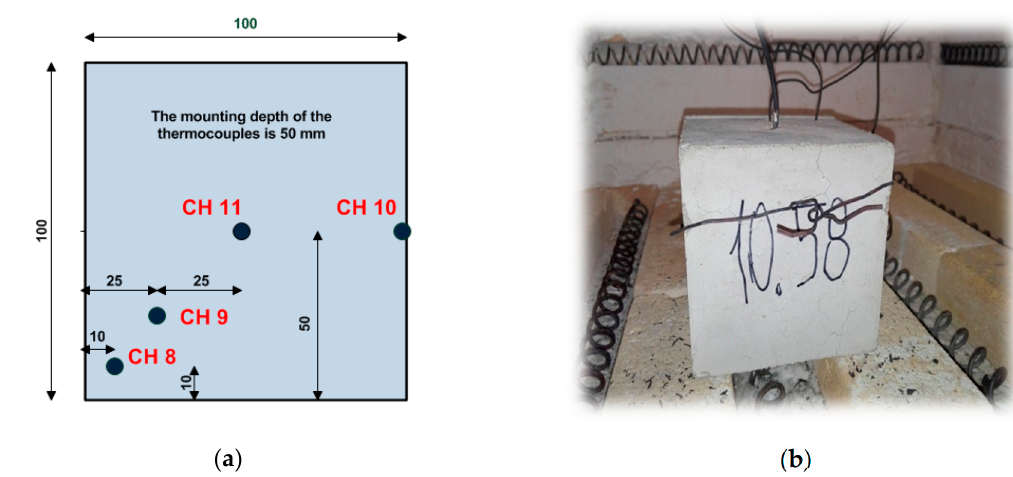
Figure 9. Cubic sample: ( a ) distribution of thermoelements; ( b ) sample with thermocouples.